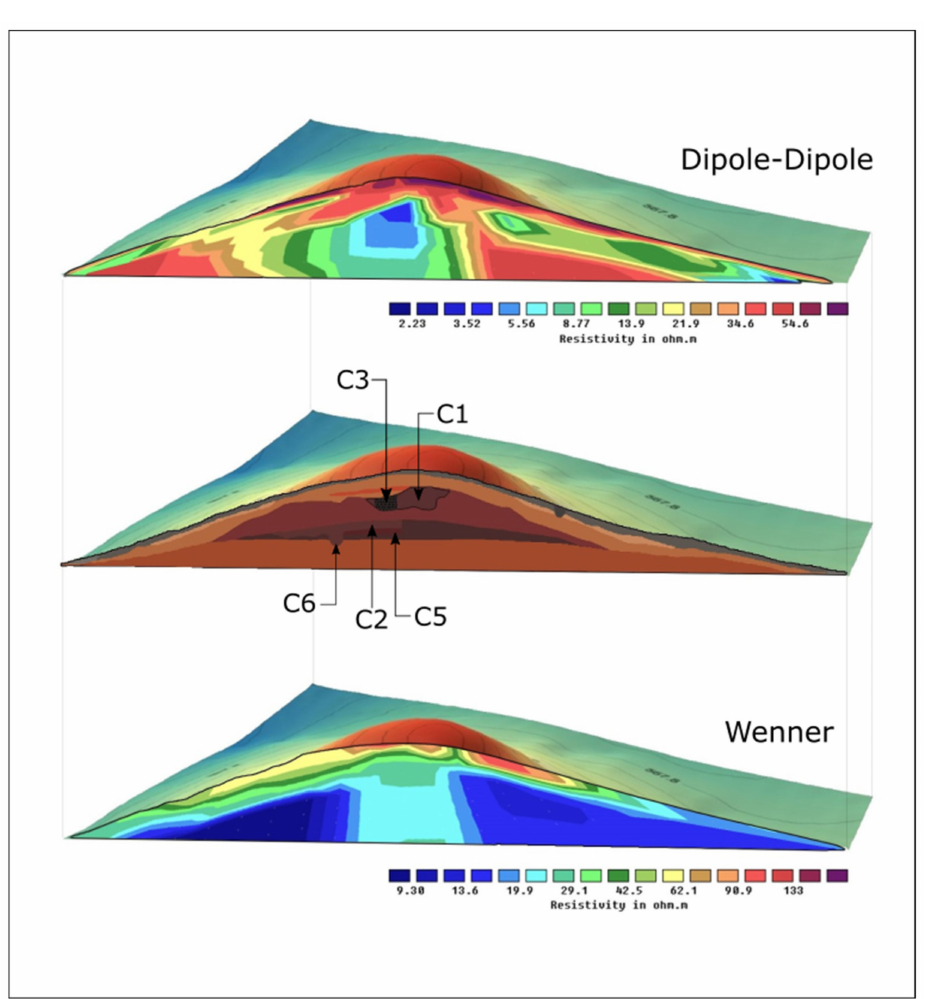
Figure 15. A comparison between ERT Profile 6 and the archaeological excavation northern profile presented in Diaconescu 2020 [24]. Archaeological feature C1 is visible on both configurations (Wenner and Dipole–Dipole), while C3 also called M1/2015 (a grave which was latter dug in the mantle of the mound) is clearly visible on Dipole-Dipole configuration. The main layers of the mound’s stratigraphy are also visible on the ERT